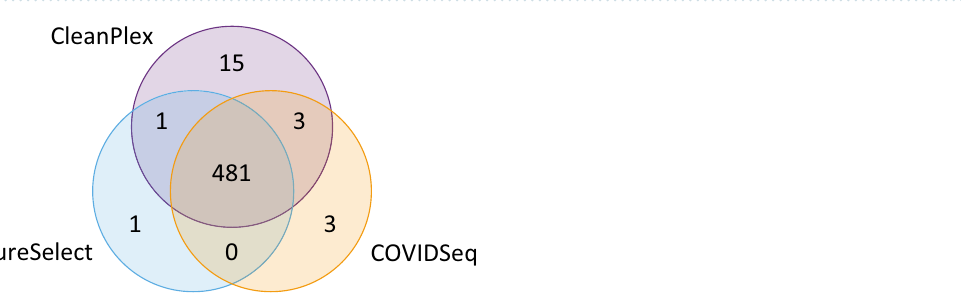
Figure 4. Comparison of variant calling profile of the same individual (lineage B.1.160). Vertical colored lines represent variants called; the absence of lines indicates a match with the reference sequence (accession no. NC_045512.2). Black arrows at the top show variant calls that differ among the three methods (in this case nt positions C7390T and G19518T).